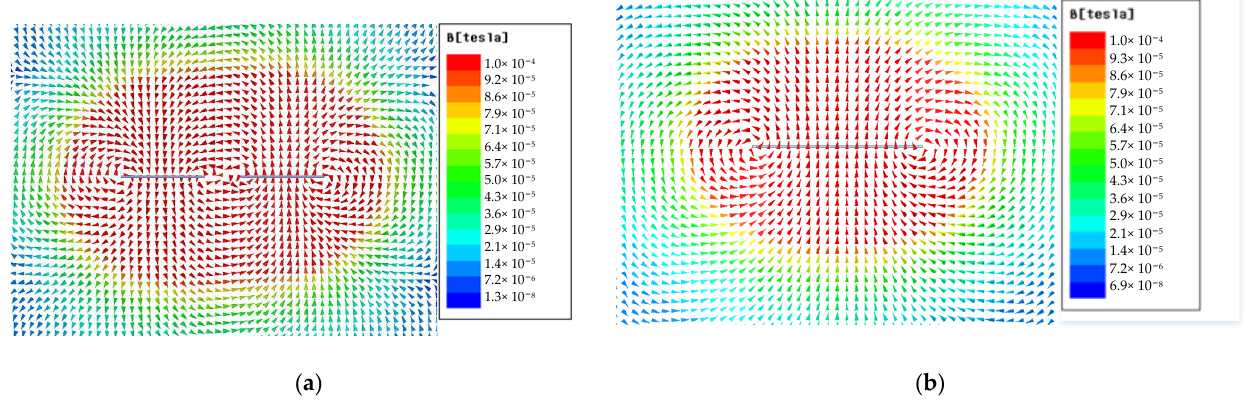
Figure 4. ( a ) Primary field of the x-component transmitting coil; ( b ) primary field of the z-component transmitting coil.